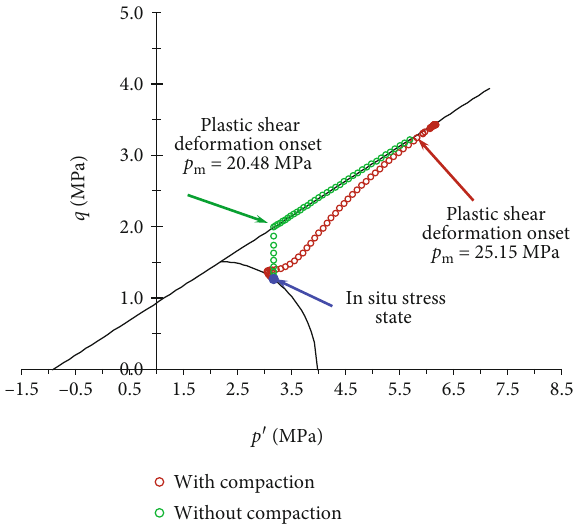
Figure 11: E ff ective stress paths experienced by a point on the wellbore surface during the drilling process (perfect fl ow barrier and p m of 25.25MPa).